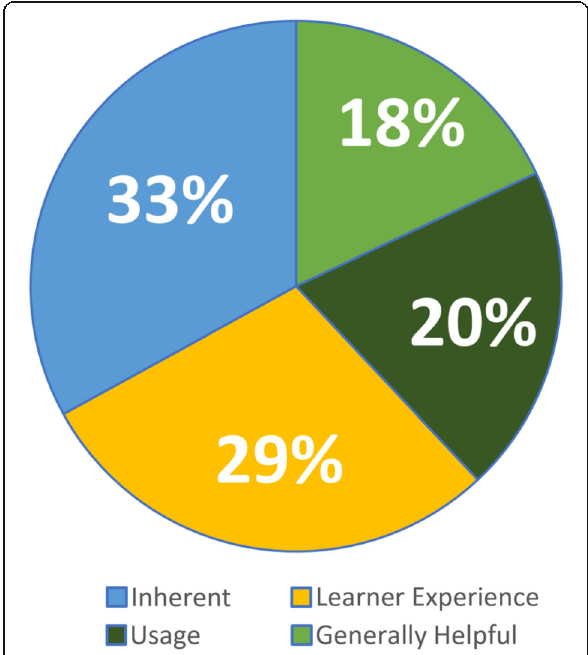
Fig. 14 Reasoning for why teachers should use video for in-person learning